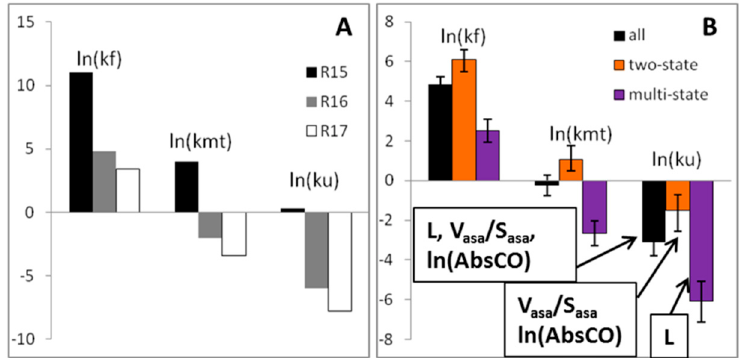
Figure 1. ( A ) Logarithm of the unfolding and folding rates for the three domains of chicken brain alpha-spectrin proteins. ( B ) The average values of the logarithm of the unfolding and folding rates for 108 proteins. Structural parameters that better correlate with the logarithm of the unfolding rates are outlined in a rectangle.